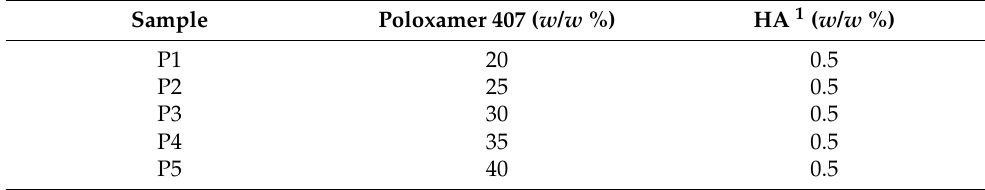
Table 1. Components in the formulation of P407-based hydrogel ( w / w % in 10 g saline).